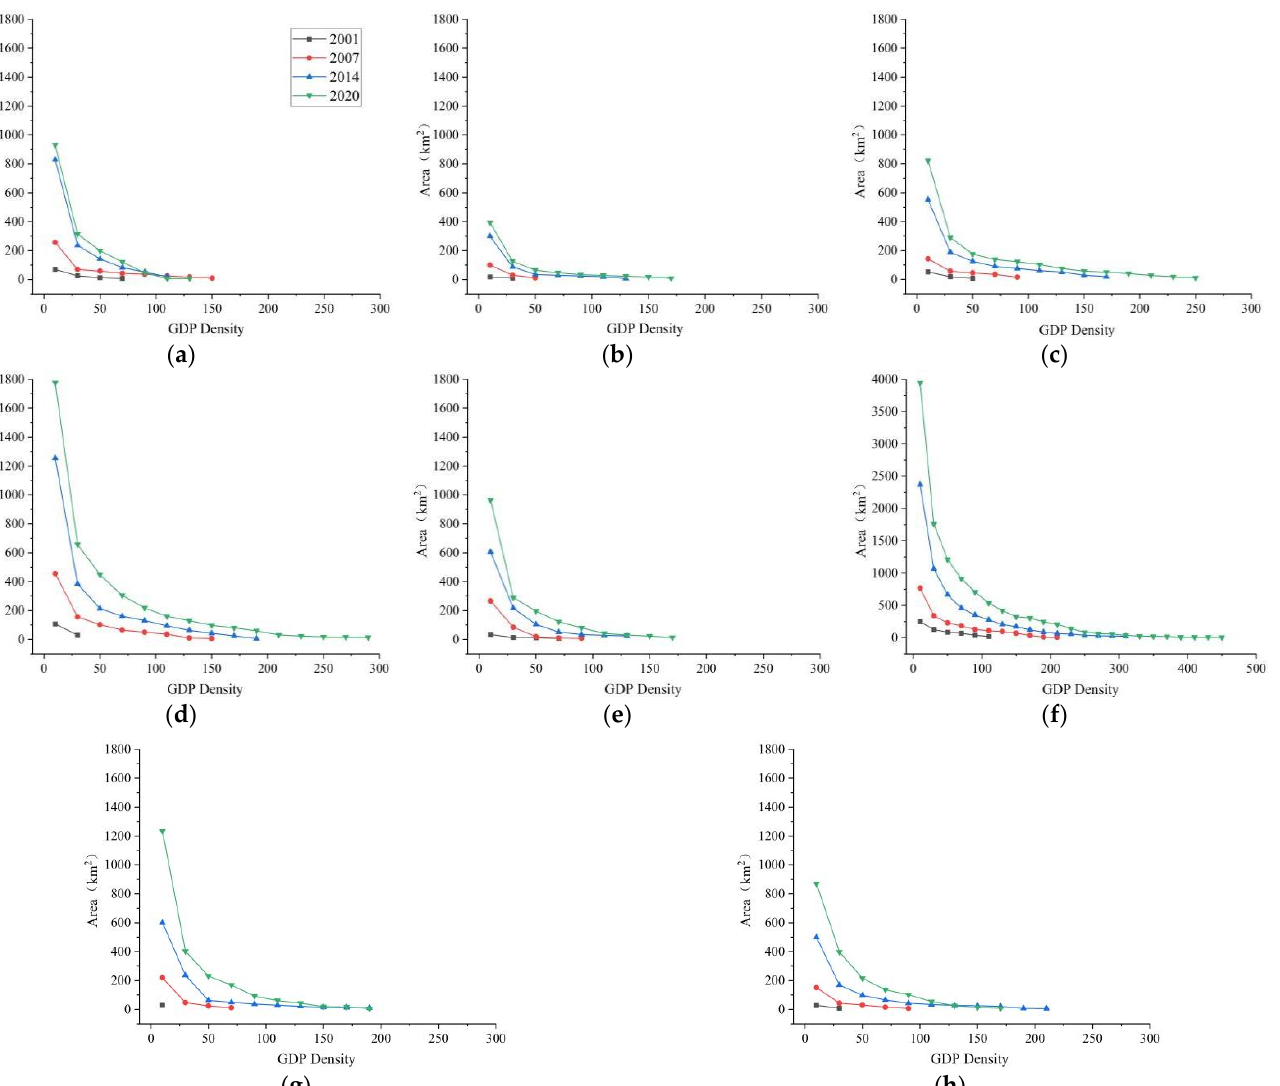
Figure 12. Histograms of tree structure information in eight cities in Henan Province: ( a ) 2001, ( b ) 2007, ( c ) 2014, and ( d ) 2020.